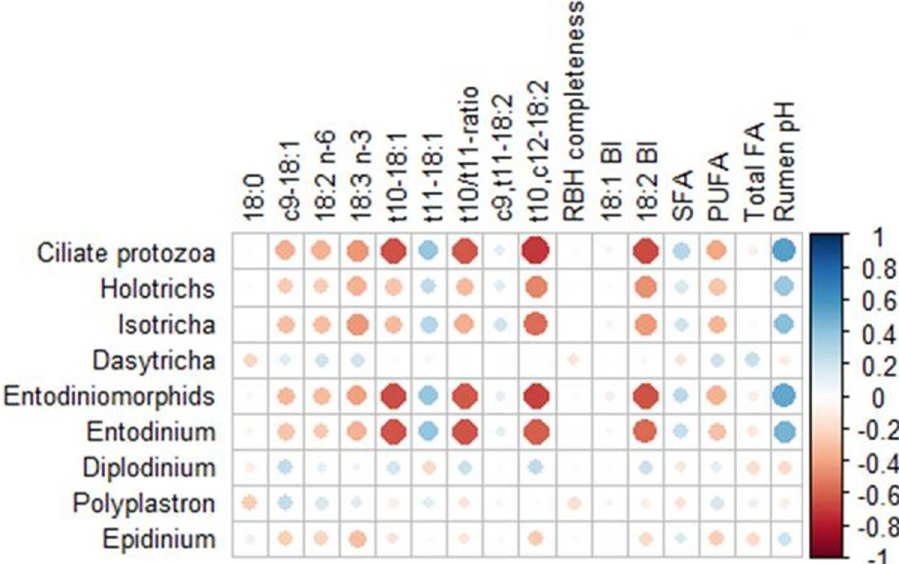
Fig 3. Significant correlations among ciliates (log 10 cells/ml) and rumen fatty acids (g/100g FA), biohydrogenation completeness (%) and rumen pH. The strongest Spearman´scorrelations are represented by large circles, while the weakest correlations are represented by small circles. The colors and their intensity on the bar scale denote the nature of the correlation, with the darker shade of blue indicating more positive correlations (close to 1) and the darker shade of red indicating more negative correlations (closer to -1) (n = 86). RBH, Rumen biohydrogenation; BI, Biohydrogenation intermediates; SFA, Saturated fatty acids; PUFA, Polyunsaturated fatty